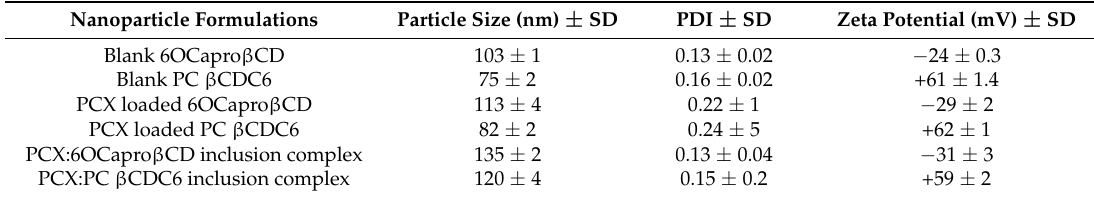
Table 1. Mean particle size, polydispersity index (PDI) and Zeta potential of blank or Paclitaxel (PCX) loaded nanoparticles ( n = 3, ±standard deviation (SD)).